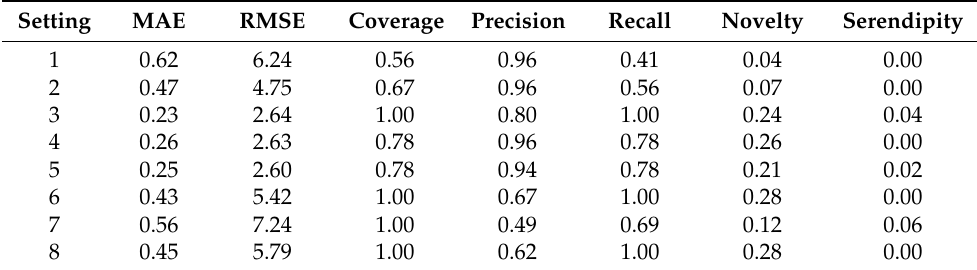
Table 5. RS performance measurements with test data (not used in the